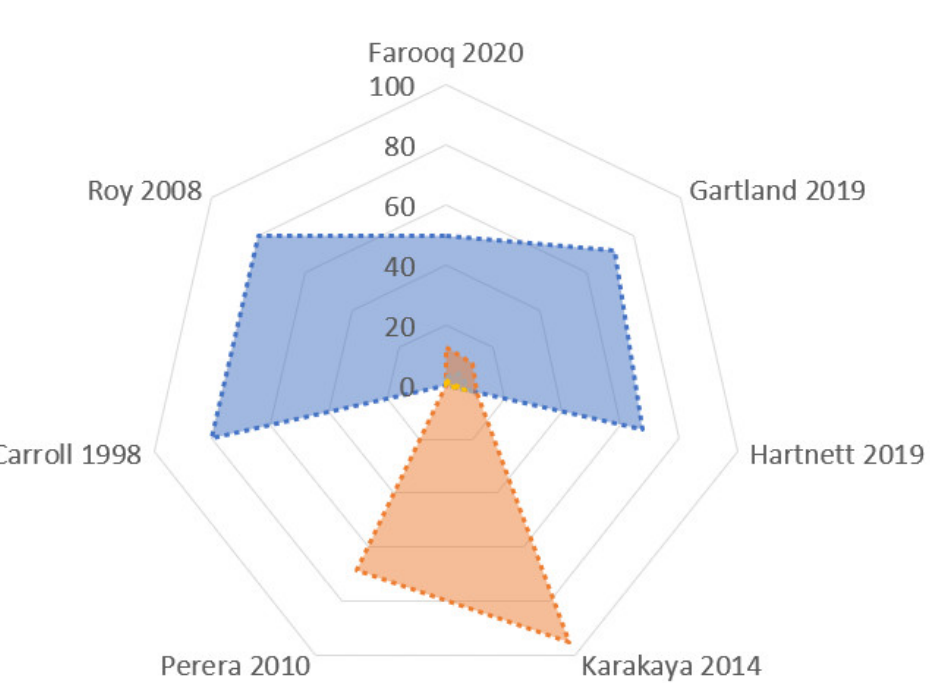
Figure 5. Radar chart: causes of litigations. The Radar chart shows two polygons, demonstrating the most common reasons of litigations (blue polygon: improper intraoperative surgical performance; pink: improper post-operative management injury). The blue polygon has the largest area, showing that, in effect, the improper intraoperative surgical performance is the most common cause of litigations. The smaller pink polygon is very asymmetrical for the heterogeneity of the rate, as reported in Table 3. The other two causes (incorrect presurgical assessment or unnecessary surgery) are very uncommonly reported, and the rate of occurrence is particularly low in the studies that analyzed this data; for these reasons, these two polygons (green and yellow) are not presented here.